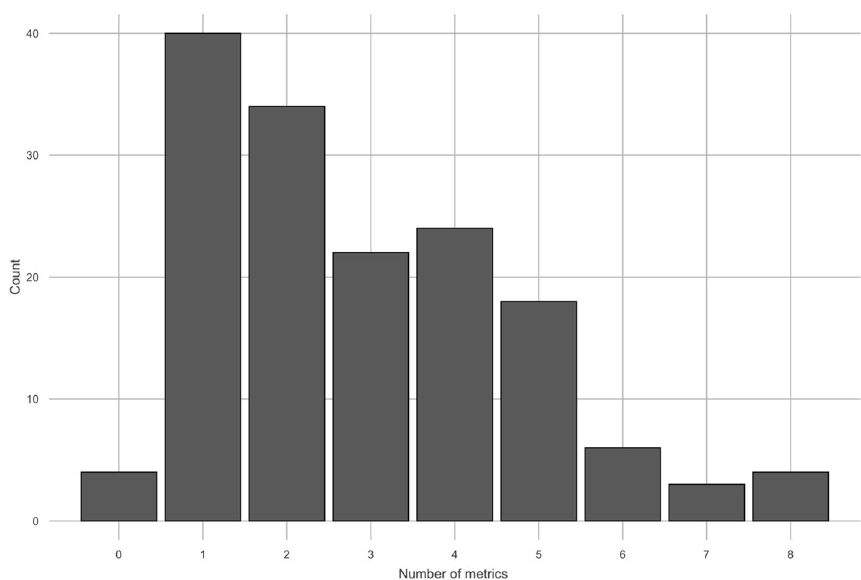
Fig. 7 Distribution of metrics based on how many metrics are adopted across the 155